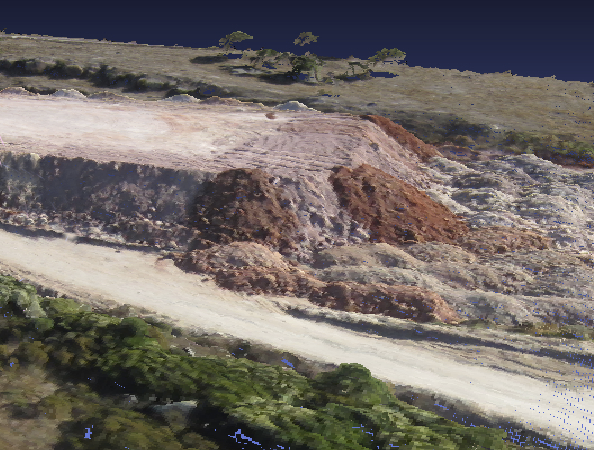
Figure 4. 3D model of the area of interest In Figure 5(a) and 5(b) two isolated portions of a couple of images of the yard, containing an object of interest, are shown.